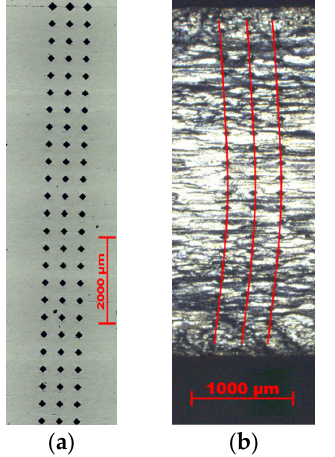
Figure 10. Hardness indents before ( a ) and after ( b ) symmetric cold rolling.